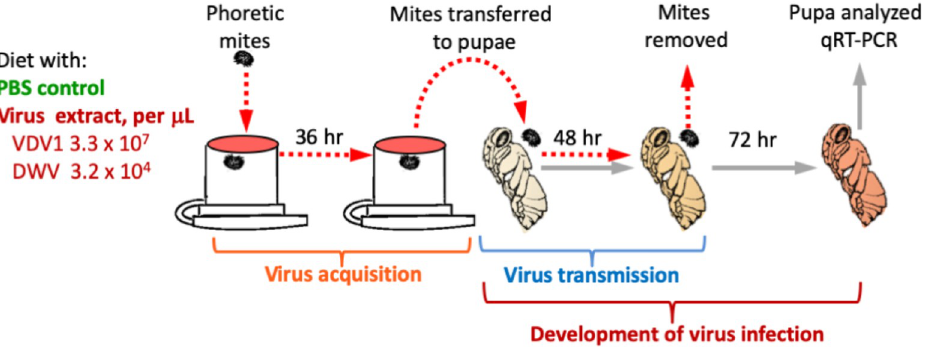
Fig 2. Application of the developed system for studying the vectoring of honey bee viruses by Varroa mites. A schematic representation of the experimental design is shown. Mites were allowed to feed for 36 h either on diet containing 1) cDNA clone derived particles of VDV-1, 3.3 x 10 7 genome equivalents per μ L, 2) wild-type DWV, 3.2 x 10 4 genome equivalents per μ L, or 3) a control diet containing PBS free of viral